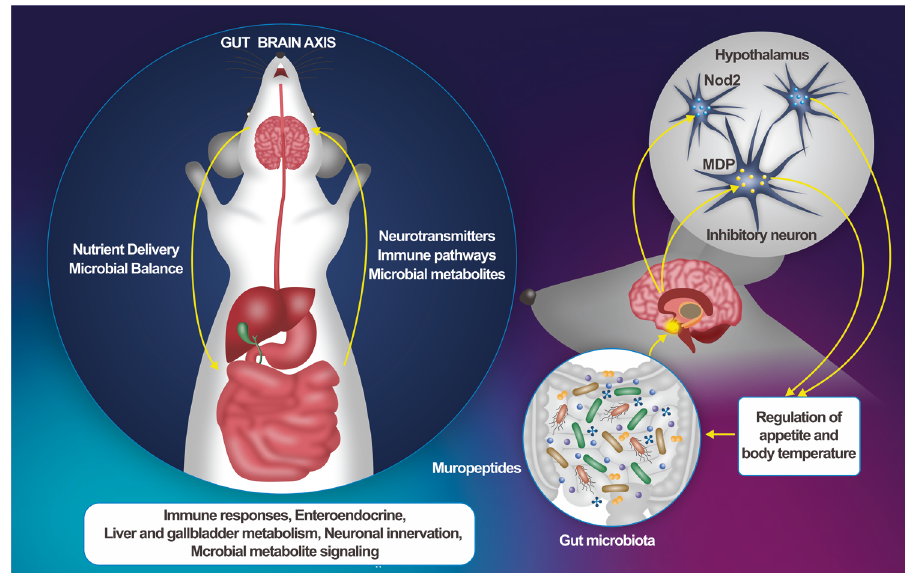
Fig. 1 Gut Brain Axis: It is a system composed of the brain and the gut in the body. The brain and the gut work together to regulate the immune responses, enteroendocrine, liver and gallbladder metabolism, neuronal innervation, microbial metabolite signaling (Left). Gut microbes affect feeding behavior by modulating brain function: the microbiota plays an important role in Nod2 ligand production and appetite regulation through Nod2-expressing hypothalamic neurons. The brain can assess food intake and regulation body temperature by sensing changes of gut microbes